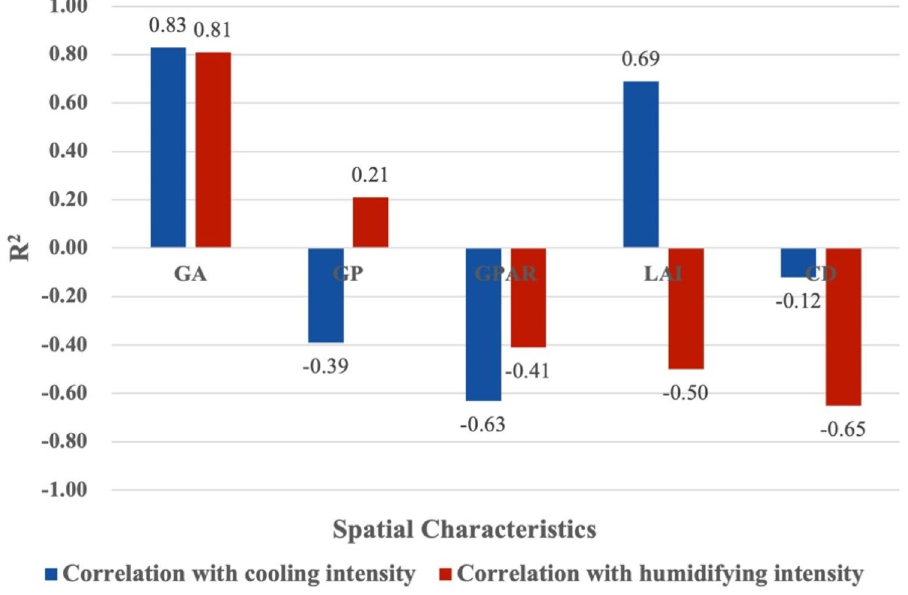
Figure 9. The correlation between the spatial characteristics of medium-size green spaces and the intensity of cooling and humidifying (GA means green area; GP means green perimeter; GPAR means green perimeter-area ratio; LAI means leaf area index; CD means canopy